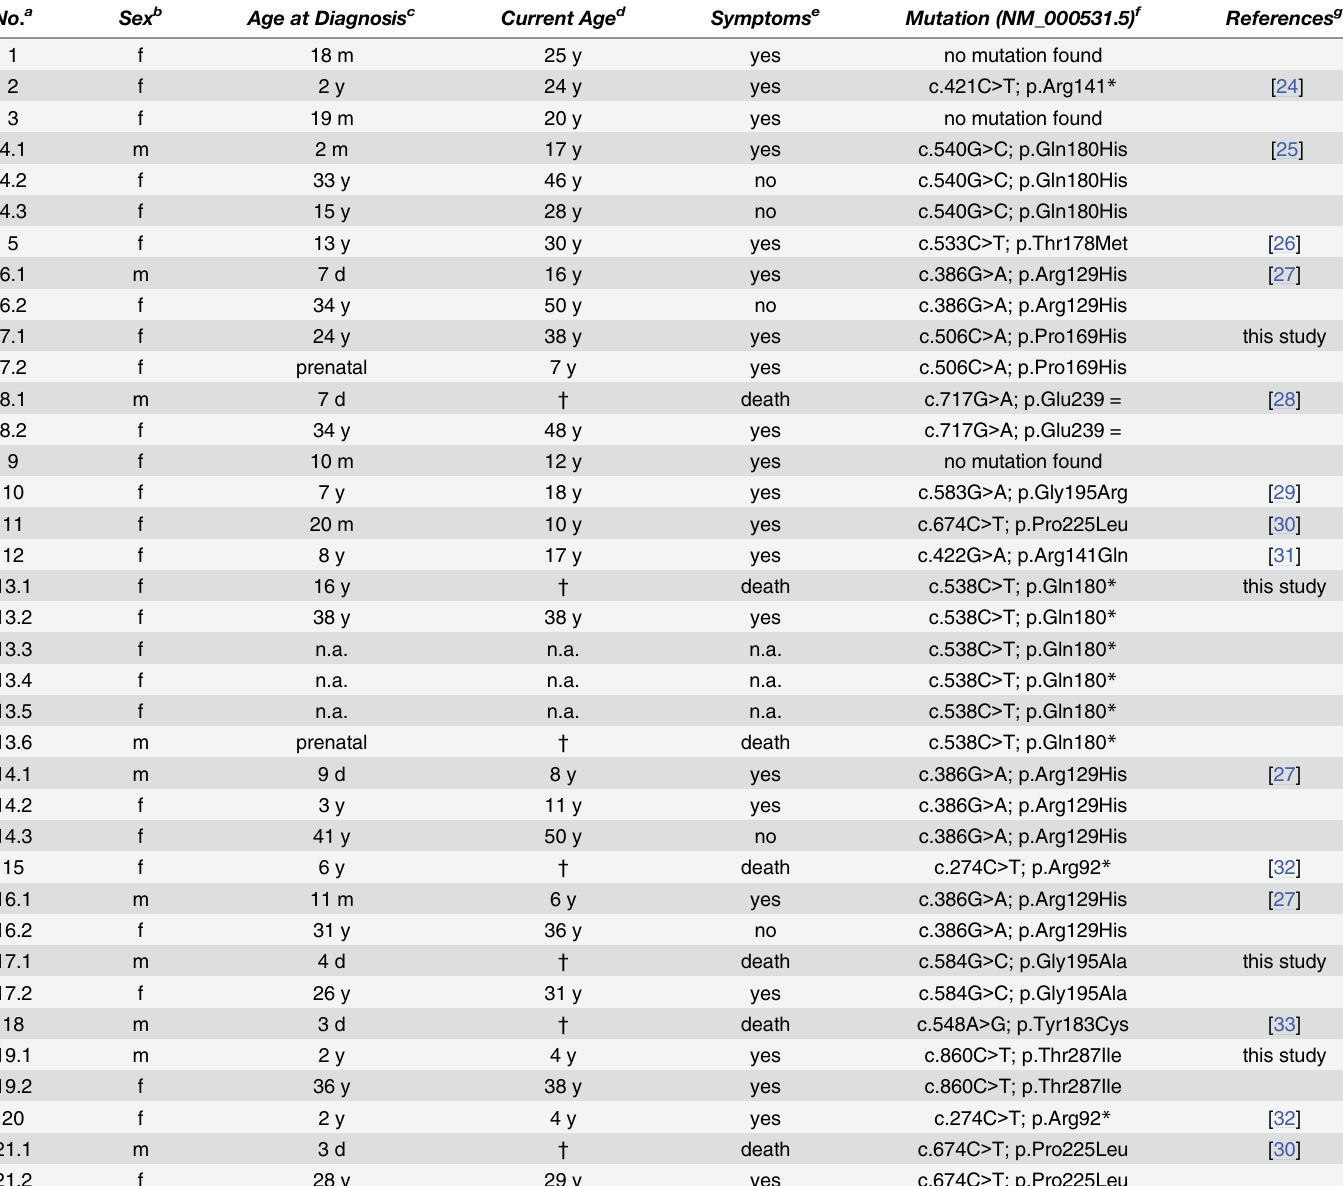
Table 1. Summary of the Swiss cohort of OTC deficient